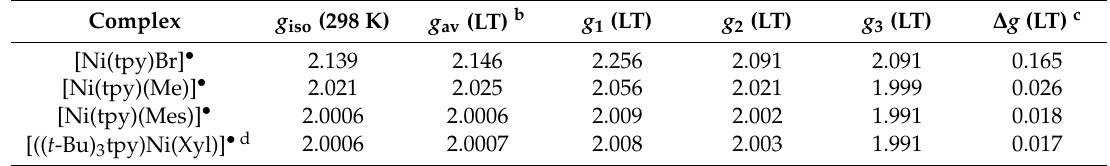
Table 1. Selected EPR data of reduced nickel tpy complexes a .